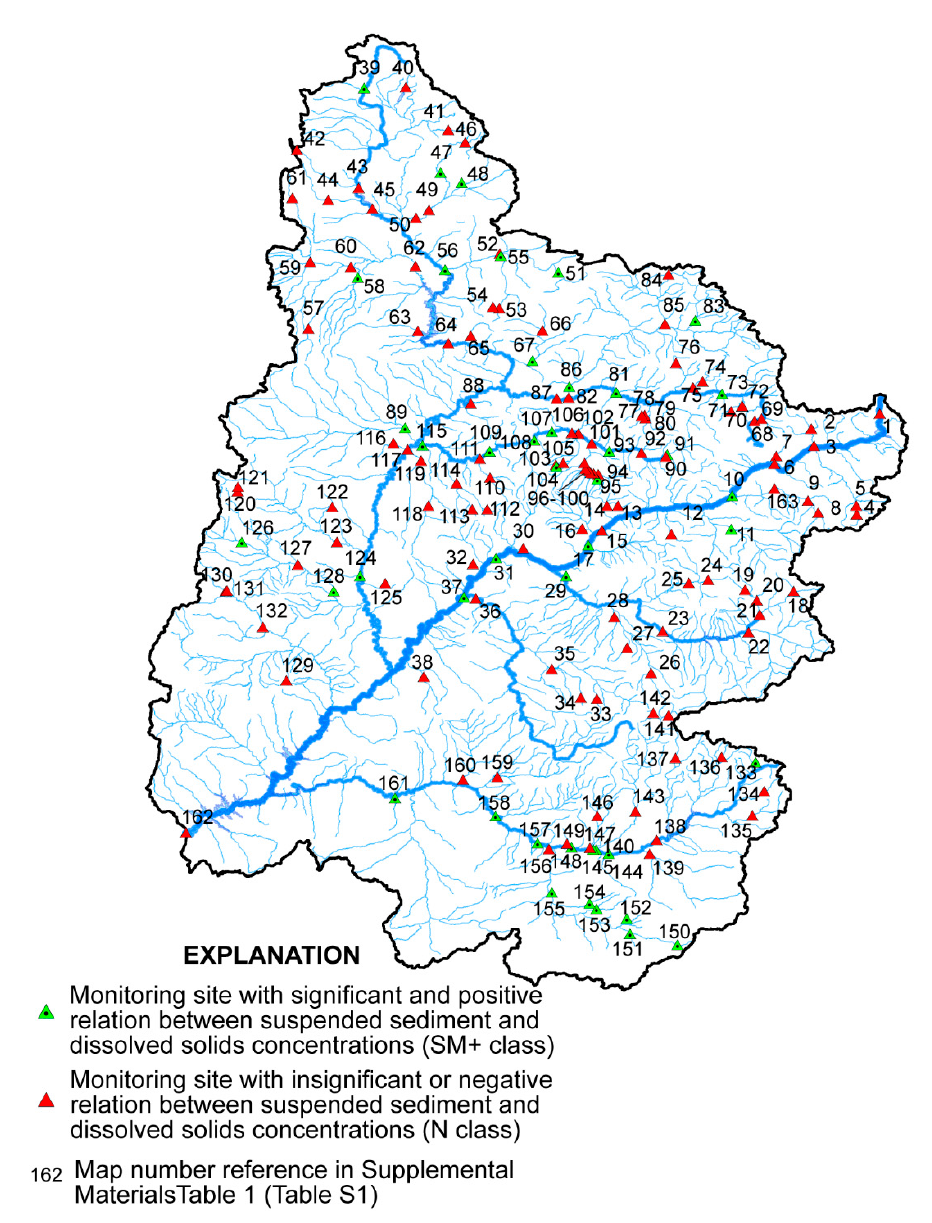
Figure 2. Location and classification of suspended-sediment and dissolved-solids monitoring sites in the upper Colorado River basin study area (adapted from the upper Colorado River basin study area (adapted from [22]).